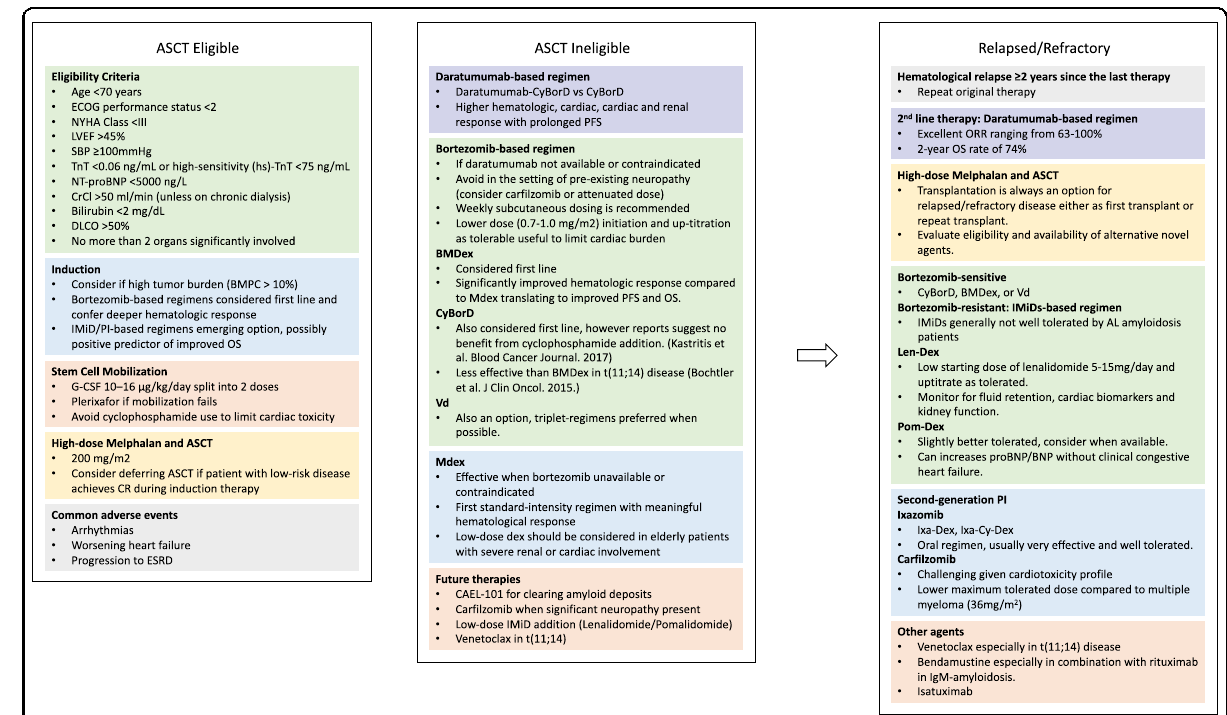
Fig. 2 Treatment algorithm for AL amyloidosis. ASCT autologous stem cell transplantation, ECOG Eastern Cooperative Oncology Group, NYHA New York Heart Association classi fi cation of the extent of heart failure, LVEF left ventricular ejection fraction, SBP systolic blood pressure, TnT troponin T, CrCl creatinine clearance, DLCO diffusion capacity of the lungs for carbon monoxide, BMPC bone marrow plasmacytosis, IMiD immunomodulatory imide drugs, PI proteosome inhibitors, OS overall survival, G-CSF granulocyte colony-stimulating factor, CR complete remission, PFS progression-free survival, ESRD end-stage renal disease, ORR overall response